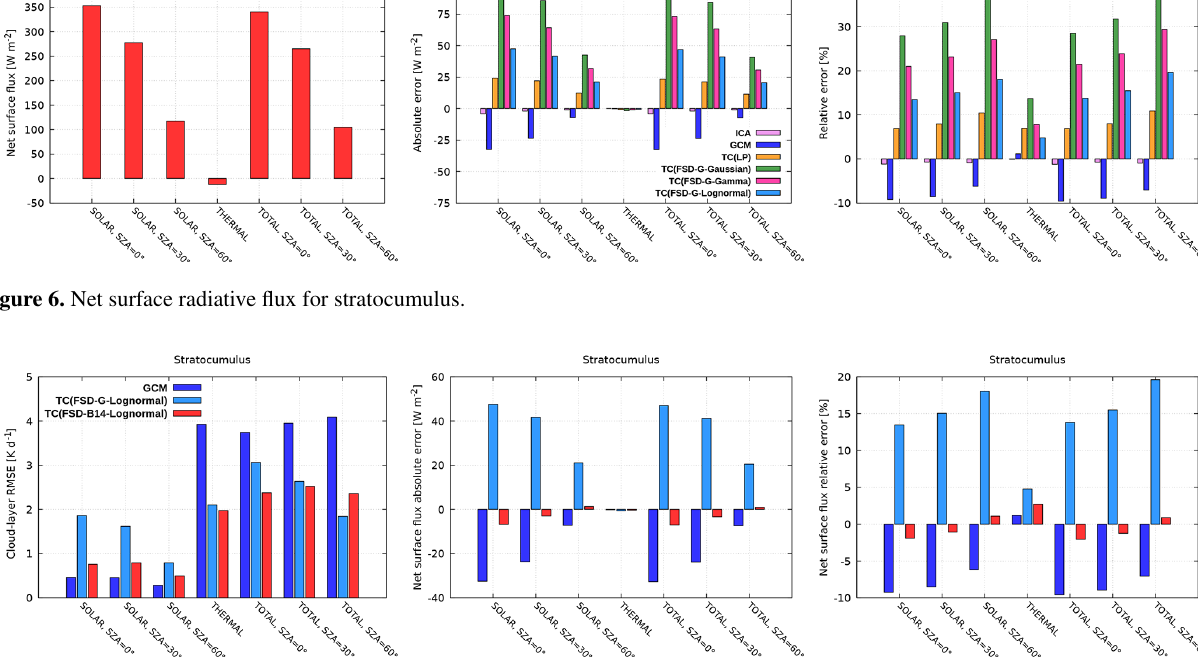
Figure 7. Optimization for stratocumulus (same experiment labeling on all